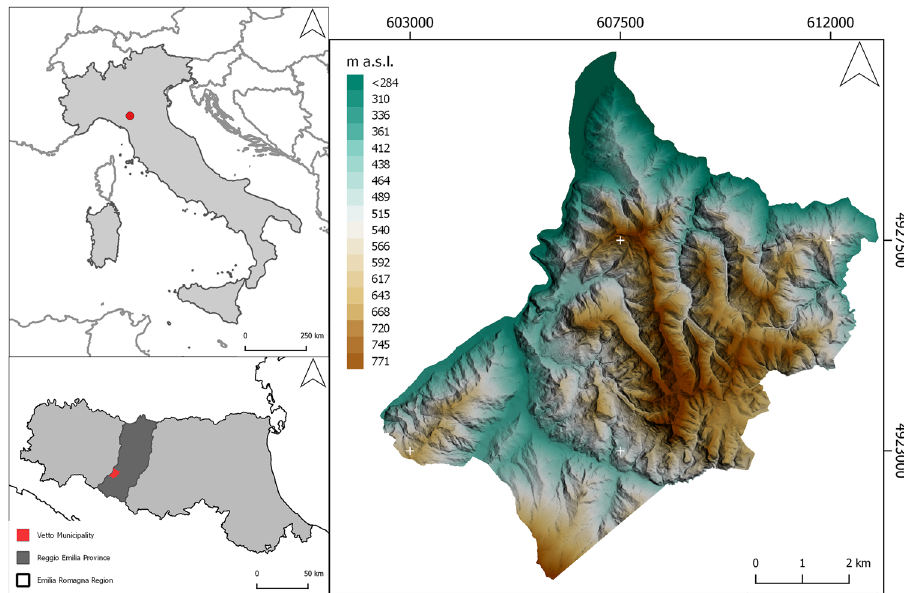
Figure 1. Case Study. Location of Vetto on the Northern Apennines (Reggio Emilia province, Italy). Image generated with the software QGIS 3.22 LTR (https:// www. qgis. org/ en/ site/ index.